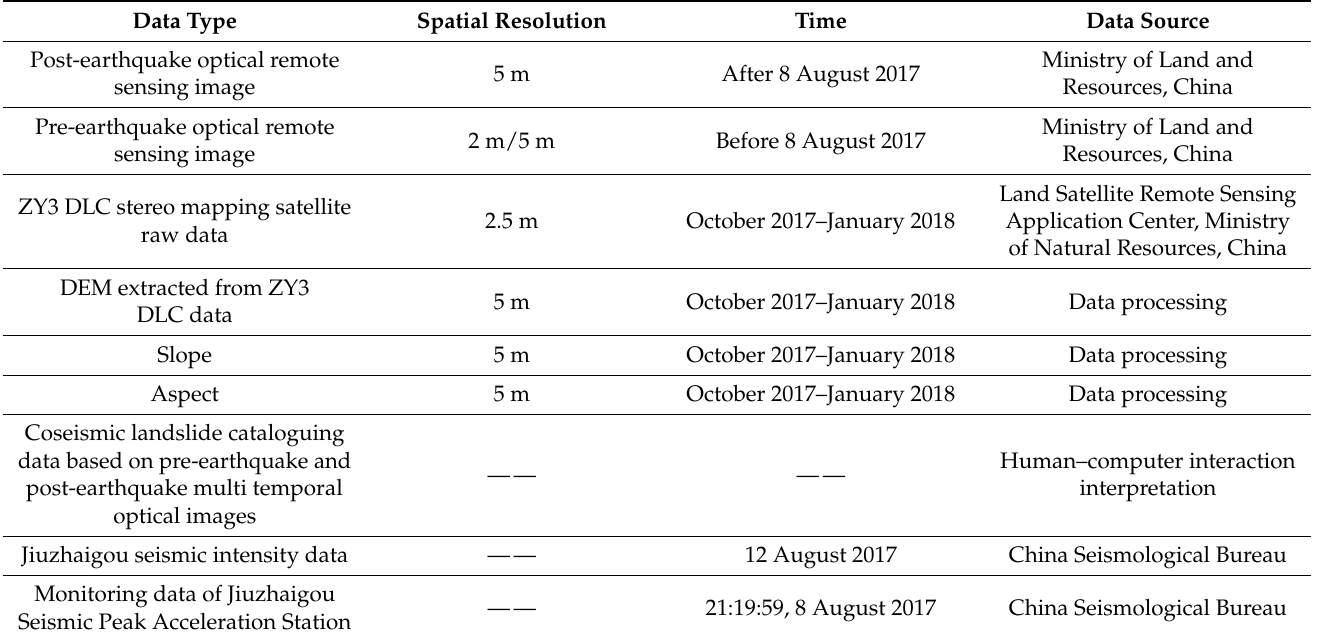
Table 1. List of data used in the